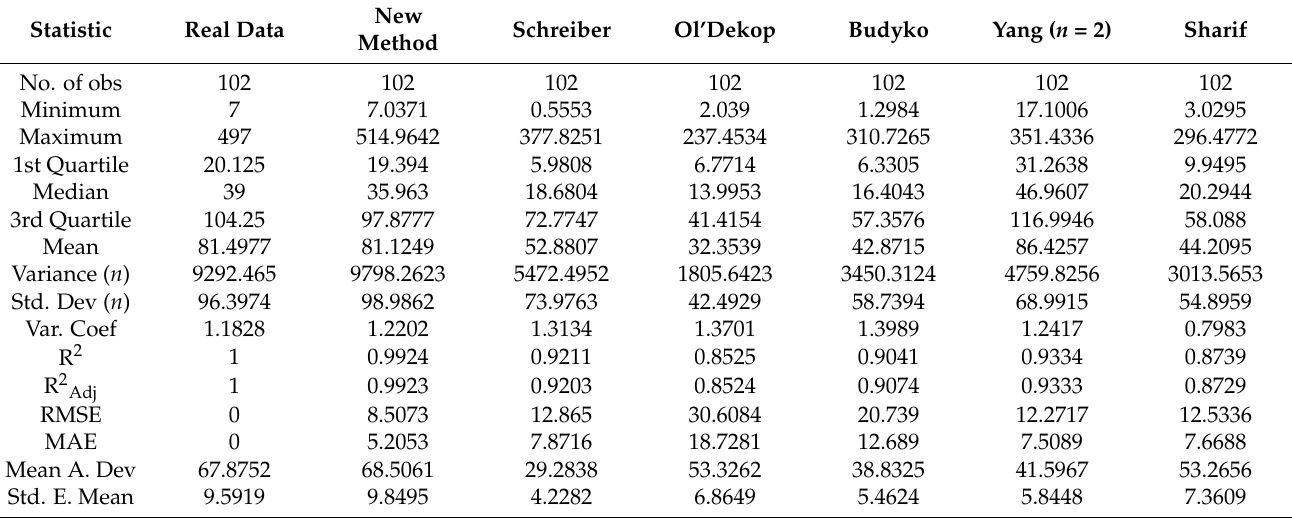
Table 7. Statistical tests and performance analysis of estimated inter-annual rainfall-runoff final results (IARR), obtained by applying a new method, Schreiber, Ol’Dekop, Budyko, Yang, and Sharif